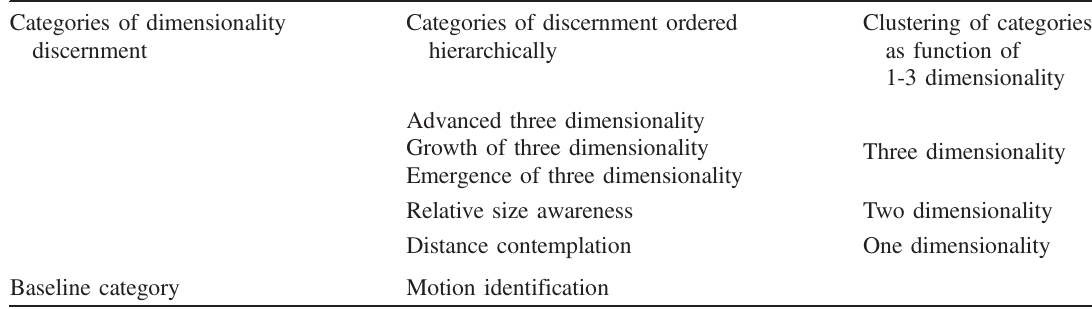
TABLE III. The multidimensionality (MD) hierarchy. This hierarchy is built by six categories of dimensionality discernment. (Following Eriksson et al.